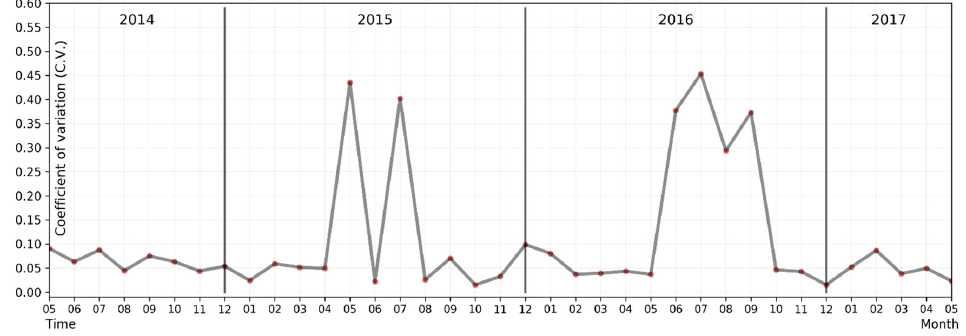
Figure 4. Distribution variation coefficient of PM 2.5 in Chinese mainland cities from May 2014